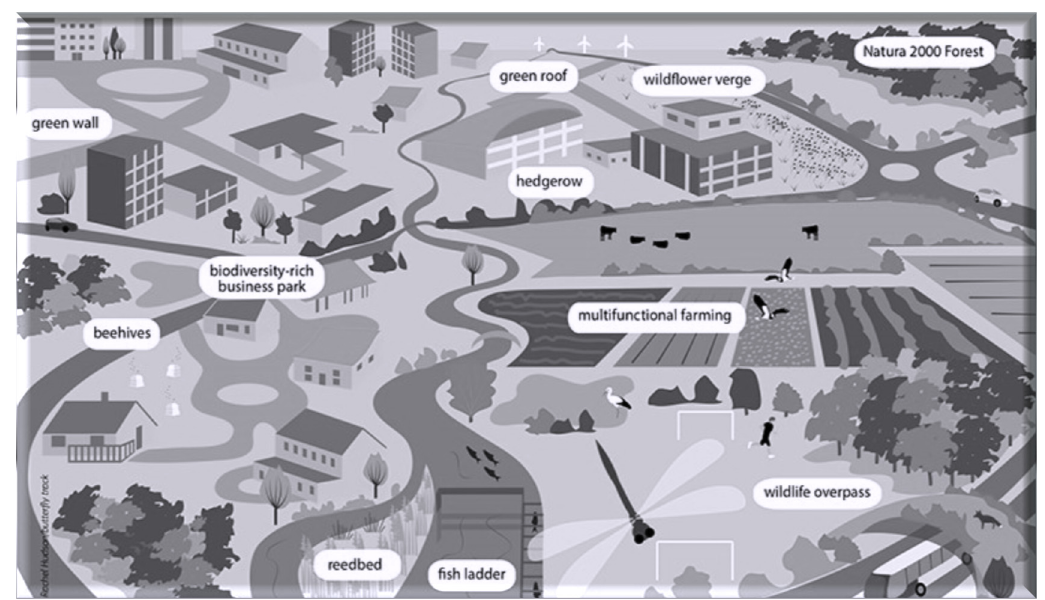
Figure 1 .The different forms of Green Infrastructures (adapted from EU 2016) [5]. Figure 1. The di ff erent forms of Green Infrastructures (adapted from EU 2016)